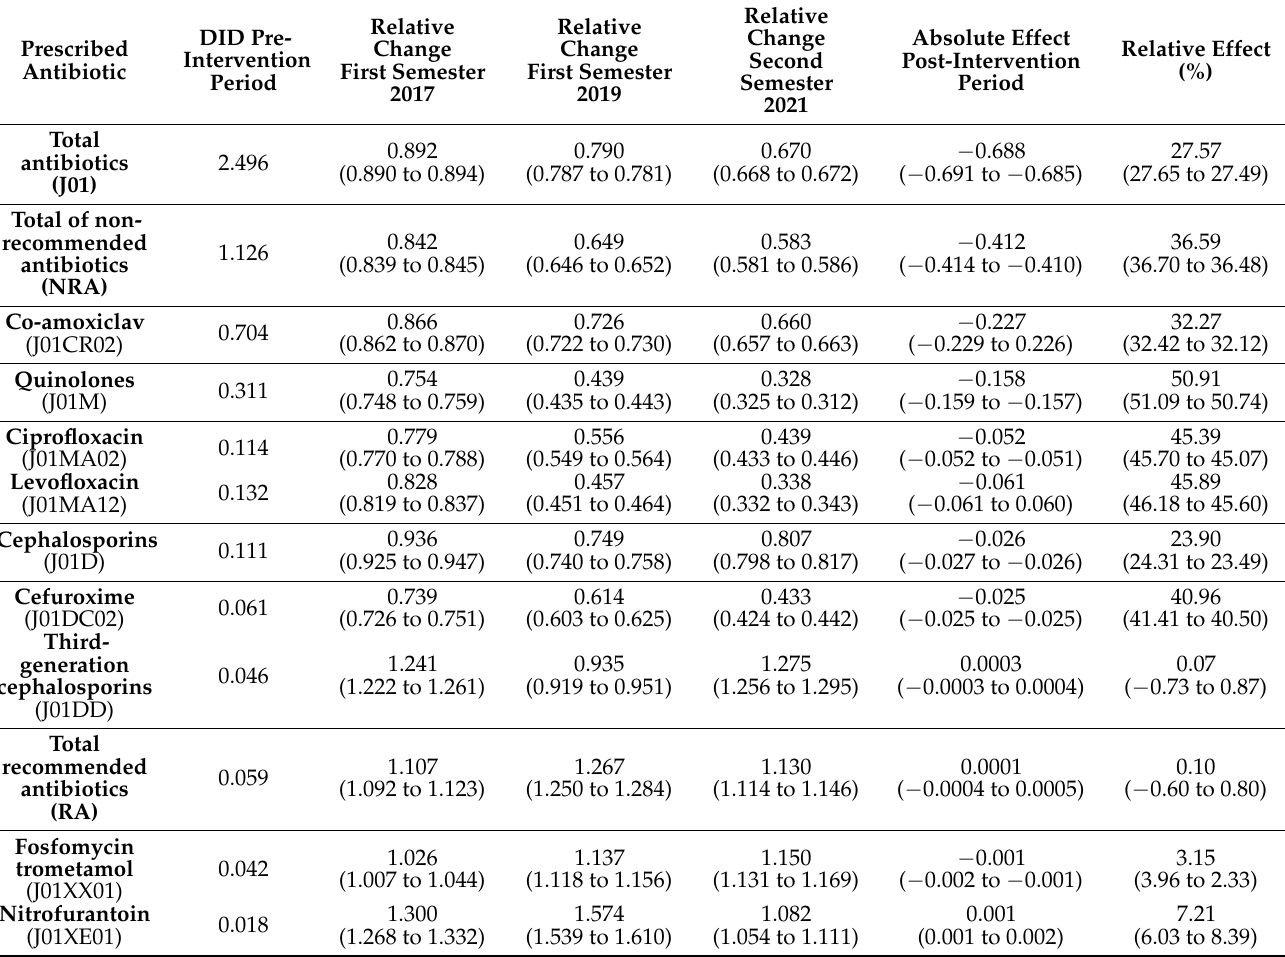
Table 1. Changes in antimicrobial prescription and final